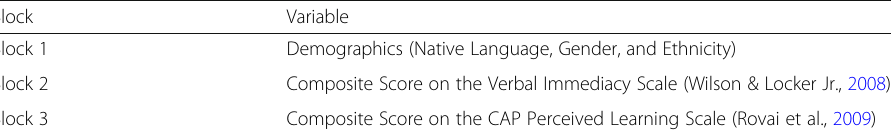
Table 3 Blocks for the HMR analysis Block Variable Block 1 Demographics (Native Language, Gender, and Ethnicity) Block 2 Composite Score on the Verbal Immediacy Scale (Wilson & Locker Jr., 2008) Block 3 Composite Score on the CAP Perceived Learning Scale (Rovai et al.,